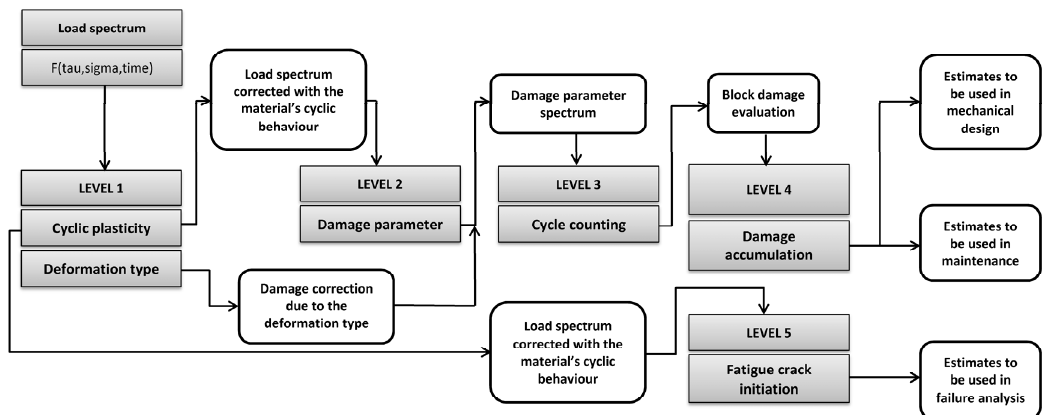
Figure 2: Fatigue estimates process under random loading conditions.